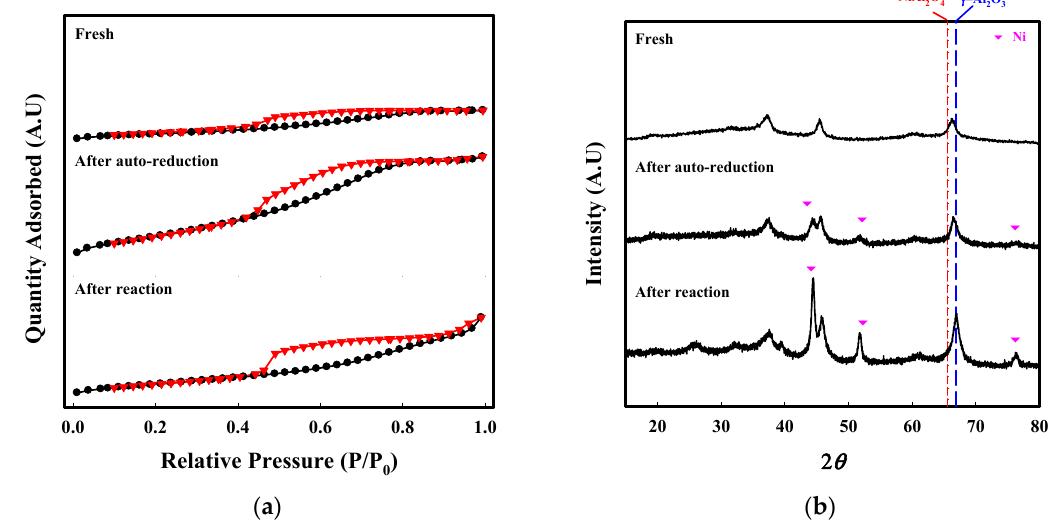
Figure 11. ( a ) Nitrogen adsorption-desorption isotherms and ( b ) XRD patterns of NA10-PM catalyst.